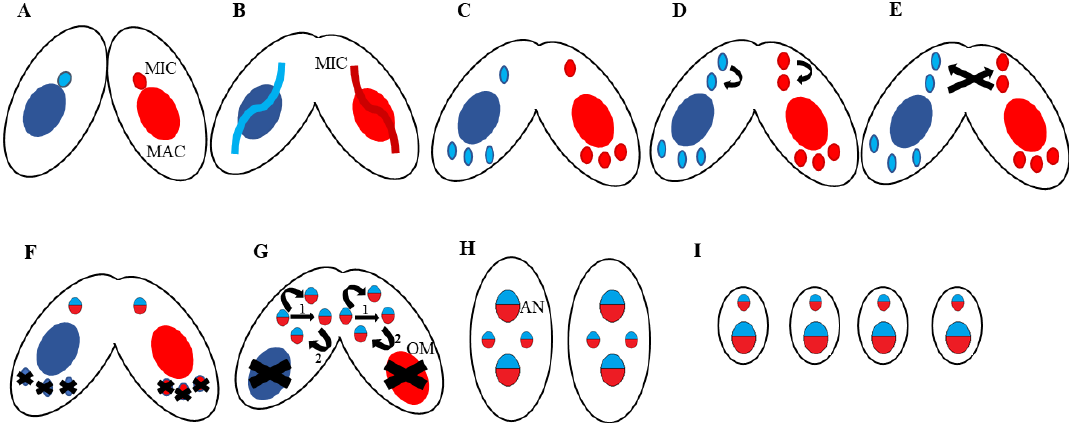
Figure 1. Conjugation (Mating) and Nuclear Development in T.thermophila . ( A ) Cell adhesion occurs at 1.5 h. ( B ) Meiosis (Prophase I) occurs at 3 h where the micronucleus (MIC) crescent is formed. ( C ) At 4.5 h, four gametic nuclei are formed. ( D ) Duplication of one of the posterior gametic nuclei occurs. ( E ) At 6 h, nuclear exchange followed by fusion of the gametic nuclei occurs, followed by, ( F ) Formation of the zygotic nucleus and elimination of the other three gametic nuclei. ( G ) At 8 h two rounds of zygotic duplication occurs, old macronucleus (MAC) (OM) degradation and new developing MAC (Anlagen (AN)) begins. ( H ) 2 Anlagen 2 MIC stage. ( I ) At 10 h separation of exconjugants occurs and at this point is when chromosome fragmentation, Internal Eliminated Sequences (IES) deletion and DNA amplification starts (~45C). At the end of conjugation there are four daughter cells.